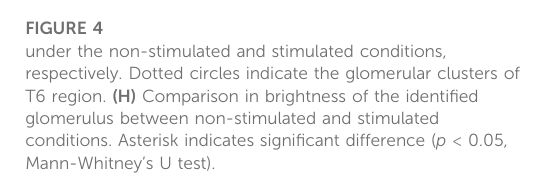
FIGURE 4 under the non-stimulated and stimulated conditions, respectively. Dotted circles indicate the glomerular clusters of T6 region. (H) Comparison in brightness of the identi fi ed glomerulus between non-stimulated and